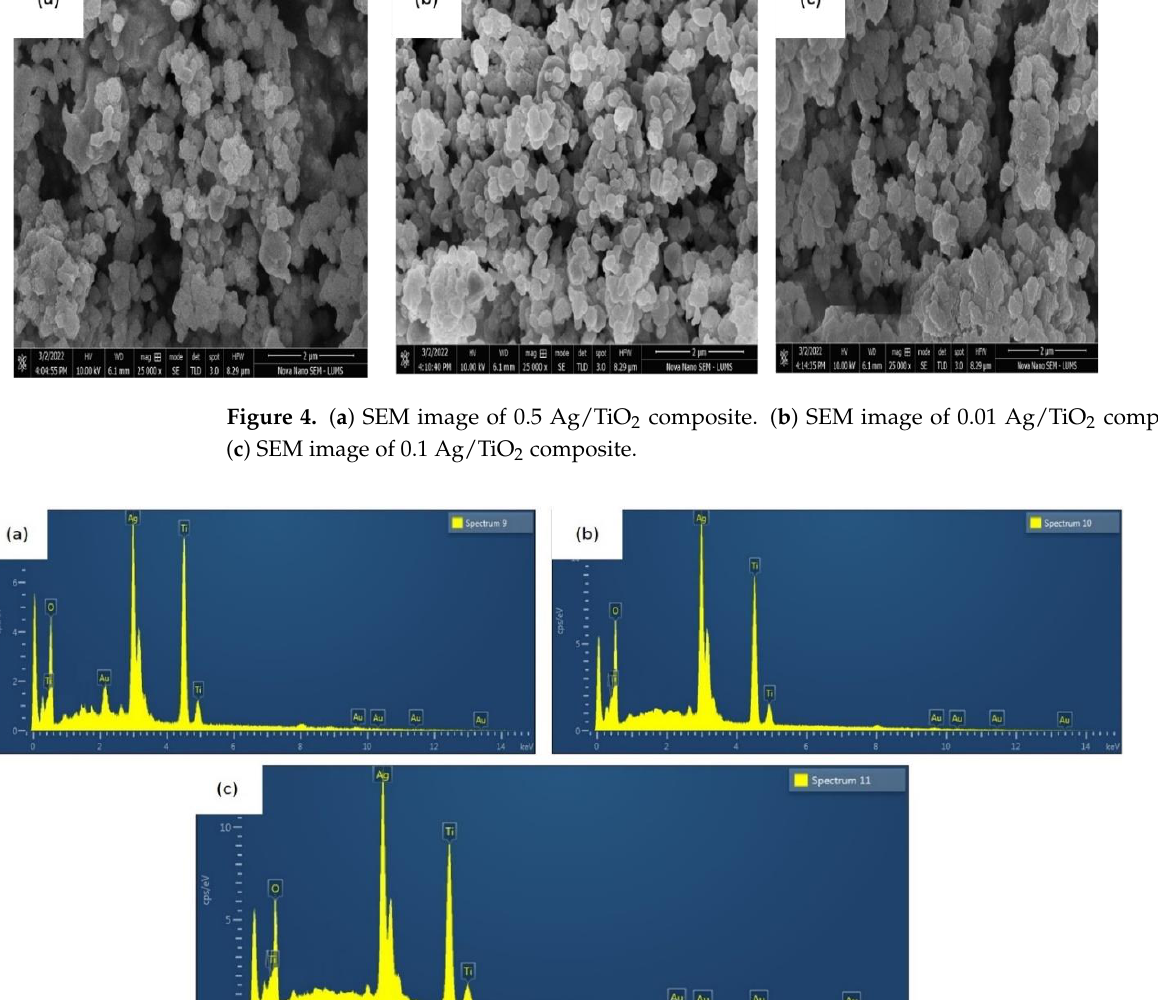
Figure 3. ( a ) XRD of 0.01 Ag/TiO 2 composite. ( b ) XRD of 0.1 Ag/TiO 2 composite. ( c ) XRD of 0.5 Ag/TiO 2 composite.